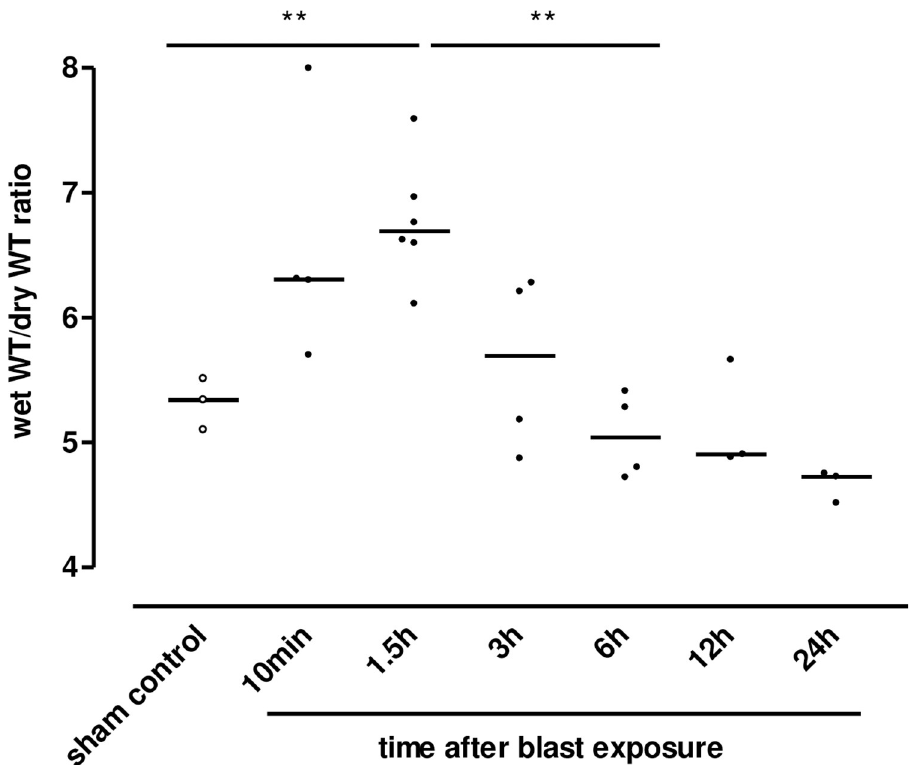
Fig 6. Thorax trauma-induced weight gain. Lung wet weight and dry weight were determined at different time- points after pressure wave exposure. The wet to dry weight ratios were calculated. Data were analysed by one-way ANOVA and Bonferroni’s multiple comparison test: �� p < 0.01 1.5 h vs. sham control and 6 h after blast,